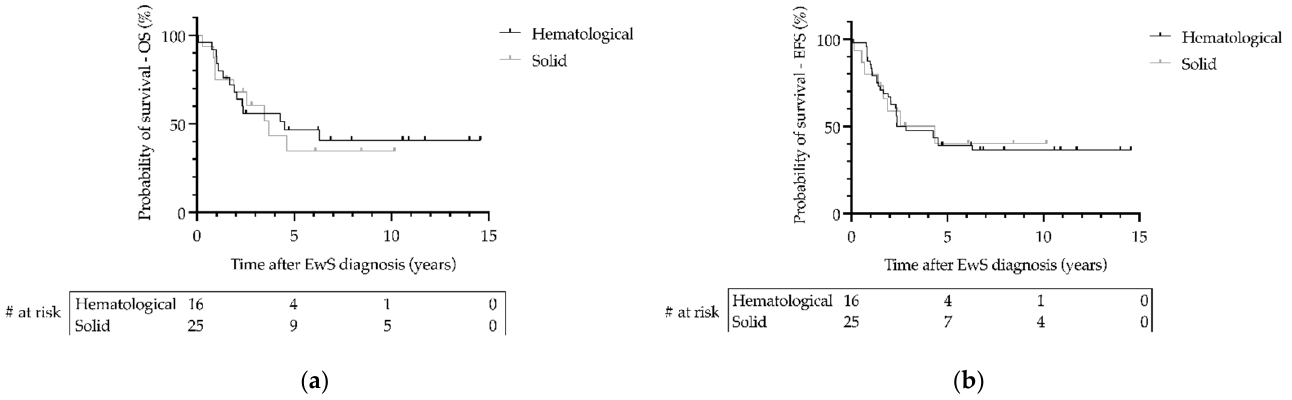
Figure 4. Survival of patients with Ewing sarcoma (EwS) as secondary malignant neoplasms as a function of type of primary hematological or primary solid malignancy in the EICESS 92, Euro- E.W.I.N.G. 99, and EWING 2008 trials. ( a ) Overall survival (OS) and ( b ) event-free survival (EFS) were calculated using the Kaplan–Meier method. Statistical analysis by Log-rank test. ( a , b ) p > 0.05. # at risk—numbers at